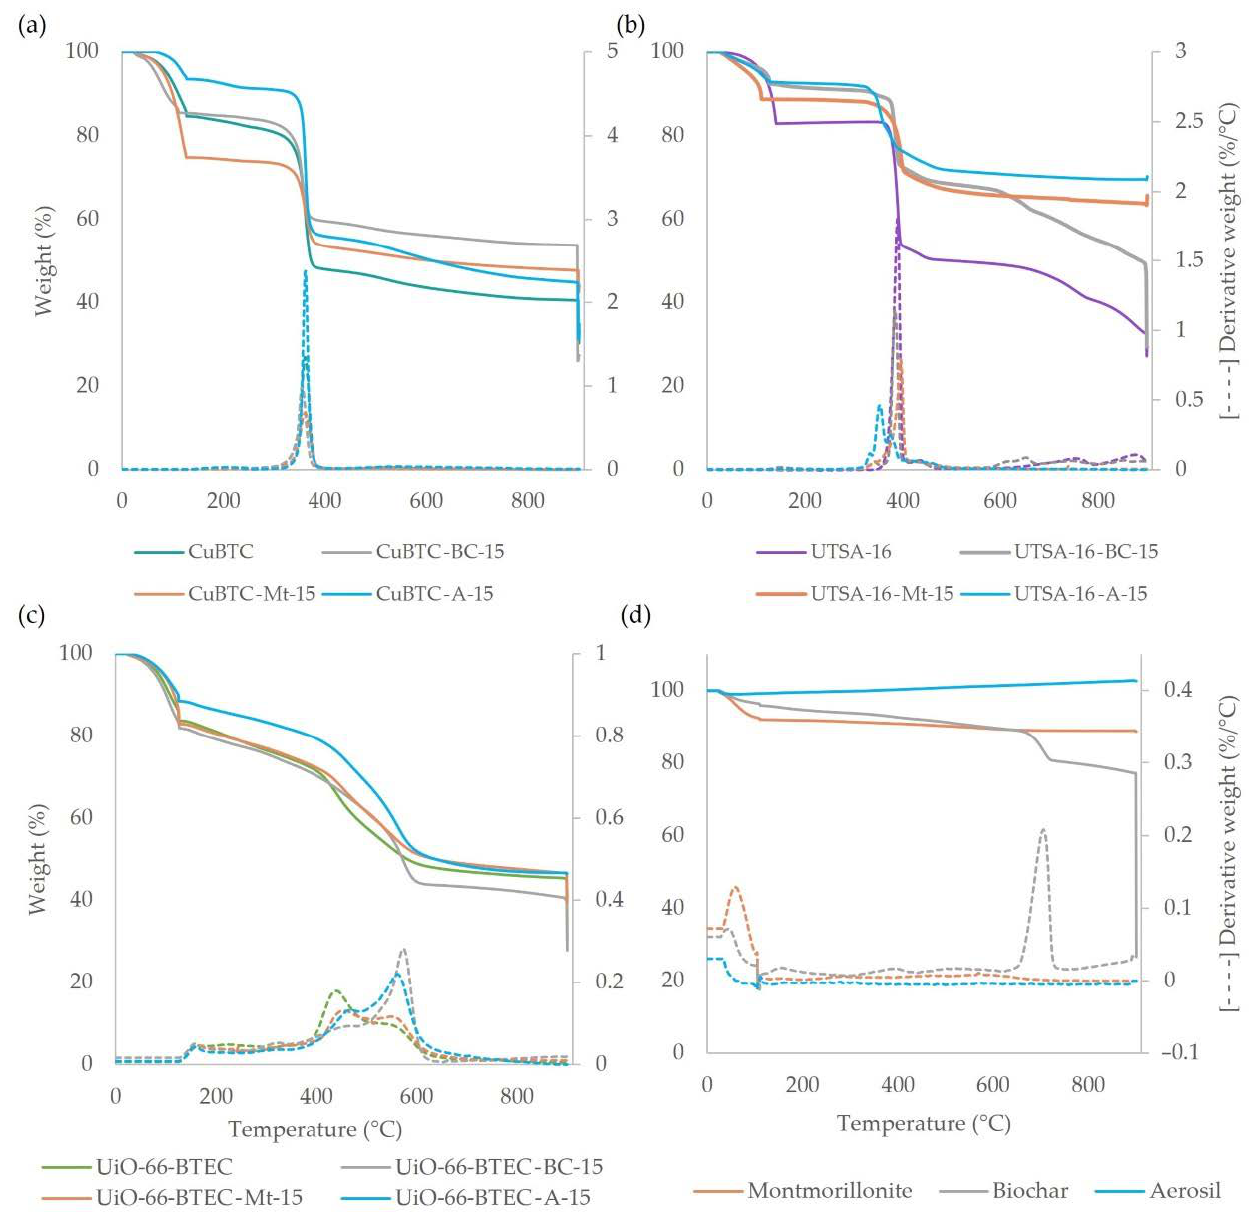
Figure 9. Thermogravimetric analysis of MOF, MOF-composites, and filler additives: ( a ) CuBTC and its composites containing aerosil (CuBTC-A-15), montmorillonite (CuBTC-Mt-15), and biochar (CuBTC-BC-15); ( b ) UTSA-16 and its composites containing aerosil (UTSA-16-A-15), montmorillonite (UTSA-16-Mt-15), and biochar (UTSA-16-BC-15); ( c ) UiO-66-BTEC and its composites containing aerosil (UiO-66-BTEC-A-15), montmorillonite (UiO-66-BTEC-Mt-15), and biochar (UiO-66-BTEC-BC-15); ( d ) filler additives.